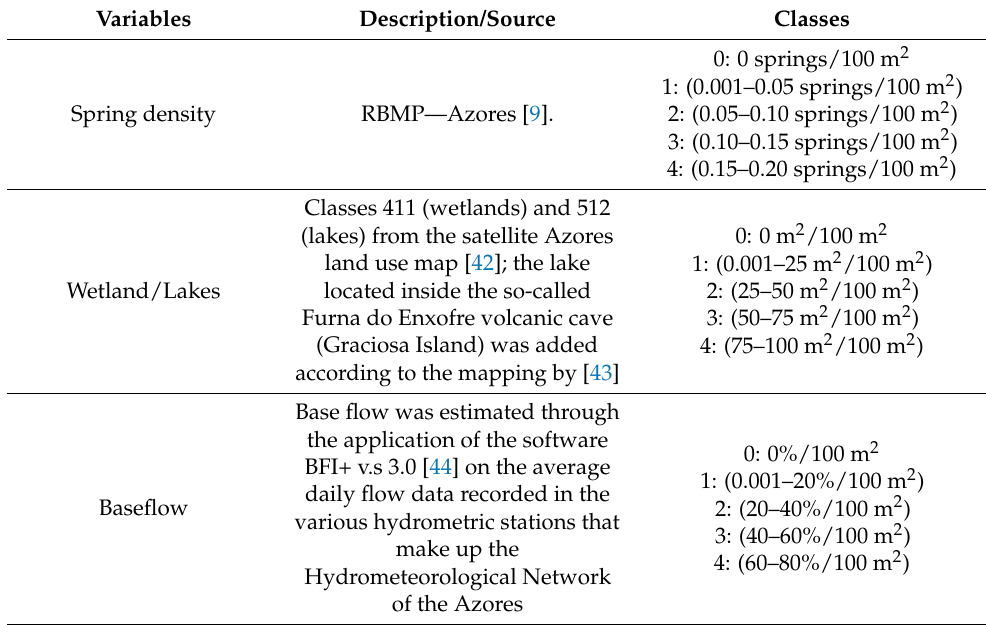
Table 2. Classes adopted for the ecosystem dependence